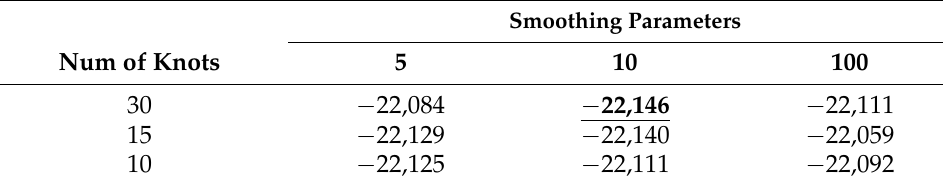
Table 12. DIC for Gamma distribution (4 January 2016, AGH, Tokyo,